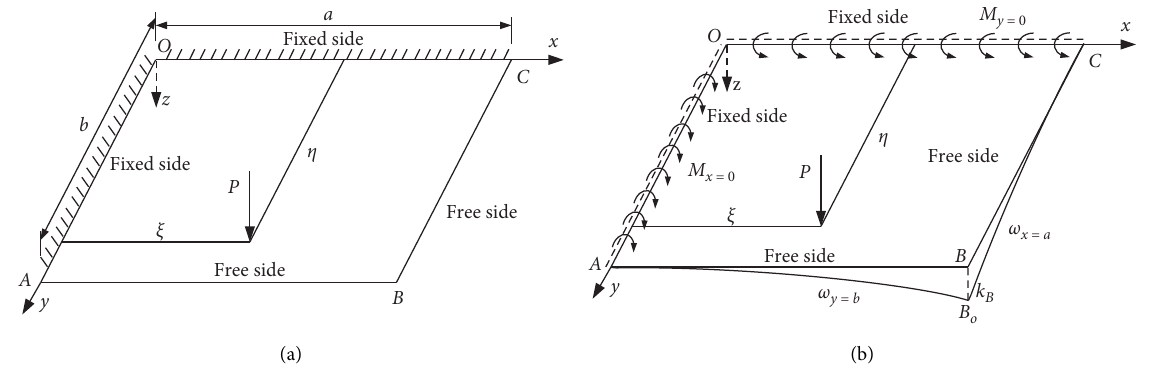
Figure 3: Mechanical models of rock plate with two adjacent sides clamped under concentrated load. (a) The actual force system and (b) equivalent system of actual